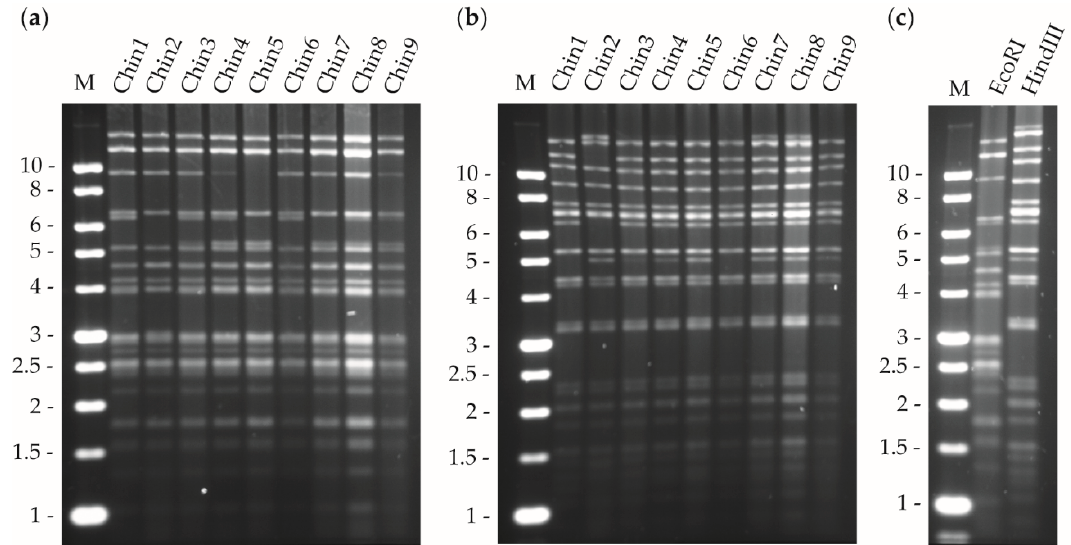
Figure 1 . Restriction endonuclease profiles of the genomic DNA of nine different field isolates from virus-killed larvae ( a ) EcoRI, ( b ) HindIII and ( c ) ChinNPV-Mex1 mixture treated with both enzymes. M is the marker and the fragment size is shown in kilobases (Kb) on the left.